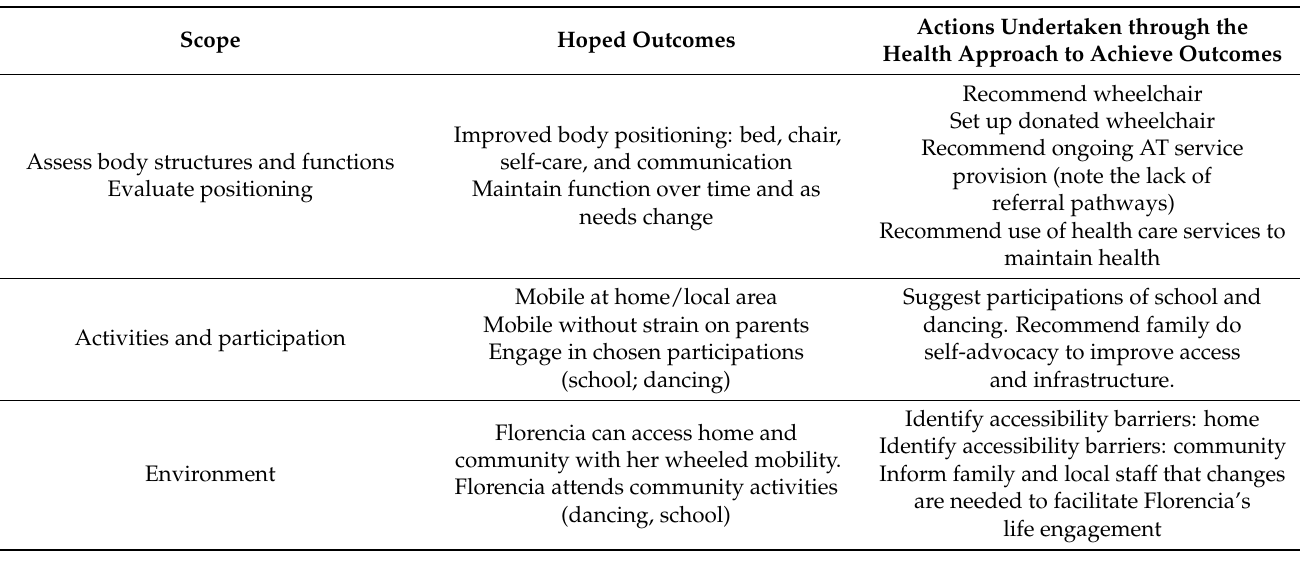
Table 2. Florencia with the rehabilitation